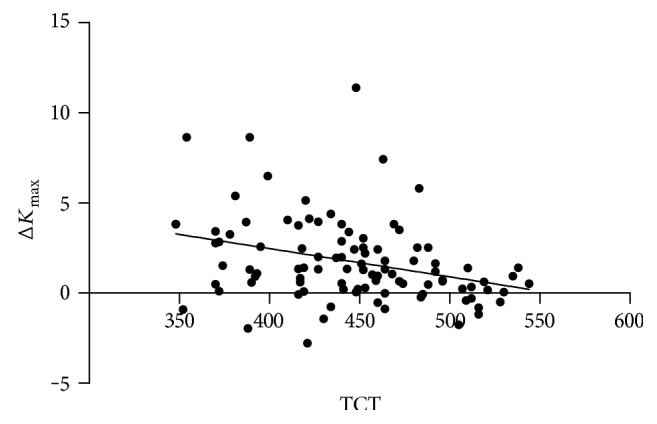
The scatter plot between TCT and ΔKmax after 6 months of treatment.